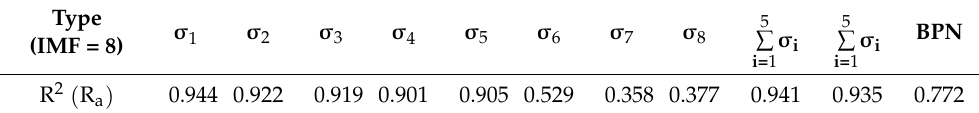
Table 2. The correlation of σ i and BPN with R a